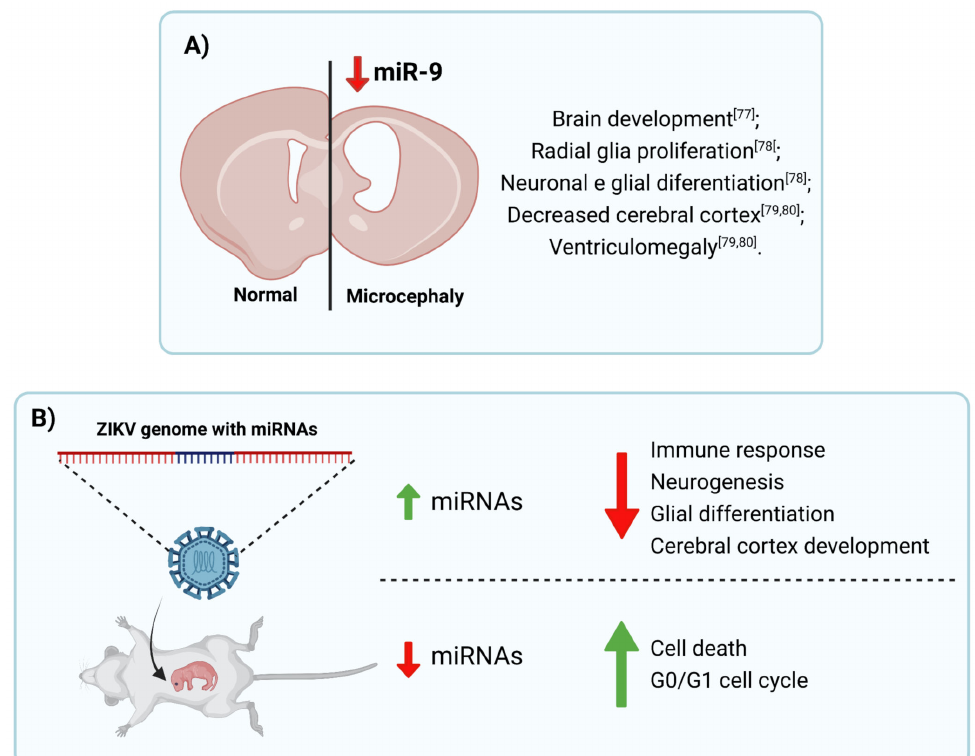
Figure 2. MiRNAs post-transcription regulation. miRNAs control ( A ) brain development and different pathway involved ( B ) in antiviral immune response, neurogenesis, cell death, and cell cycle in response to ZIKV and other flavivirus infections. Figure created by authors using